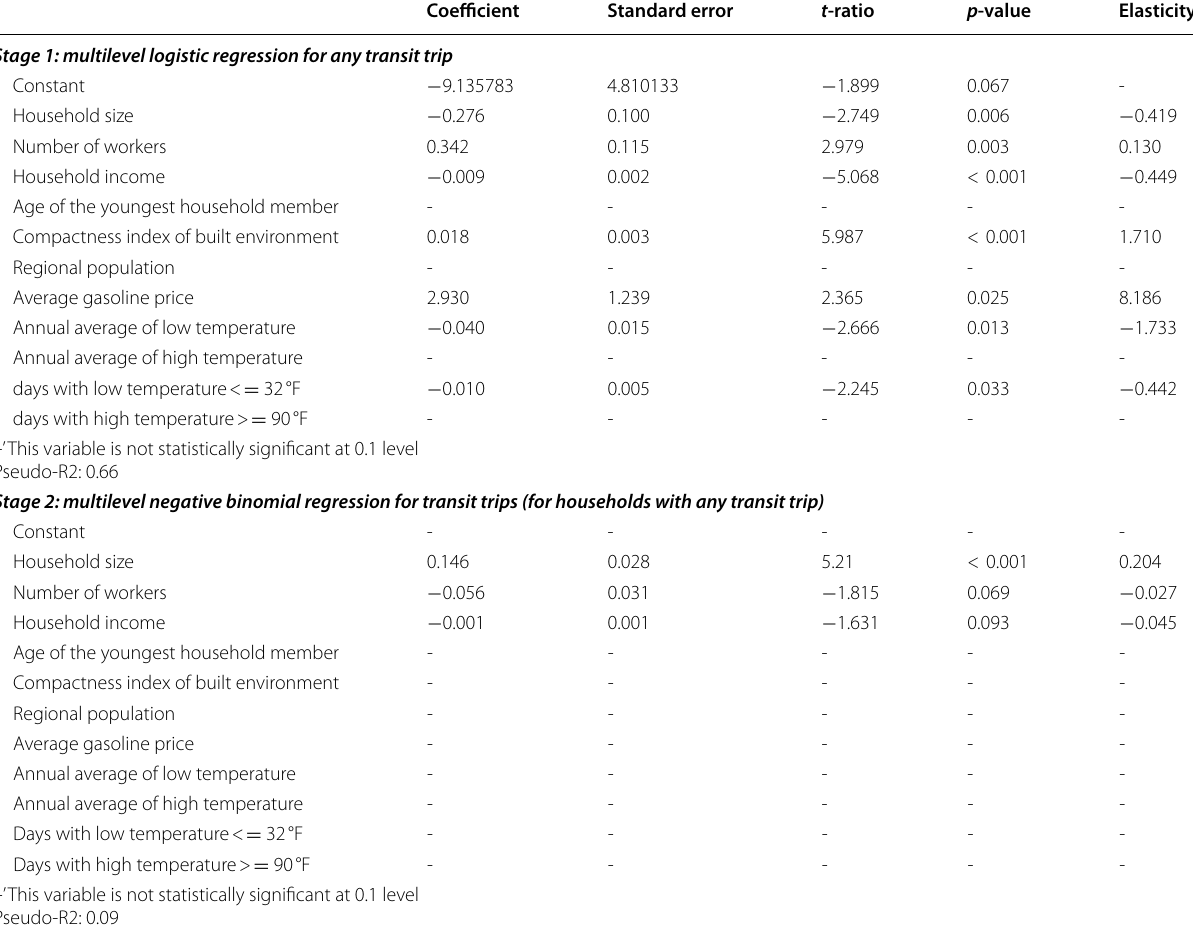
Table 8 Two-stage multilevel regressions for household transit trips Coefficient Standard error Elasticity Stage 1: multilevel logistic regression for any transit